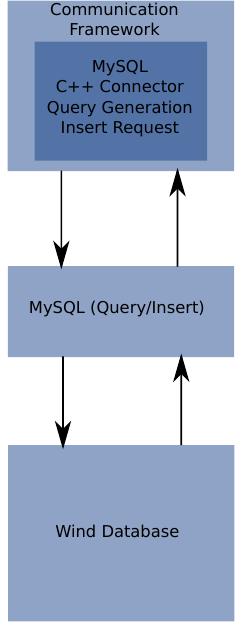
Figure 7. Database interfacing with communication handler.